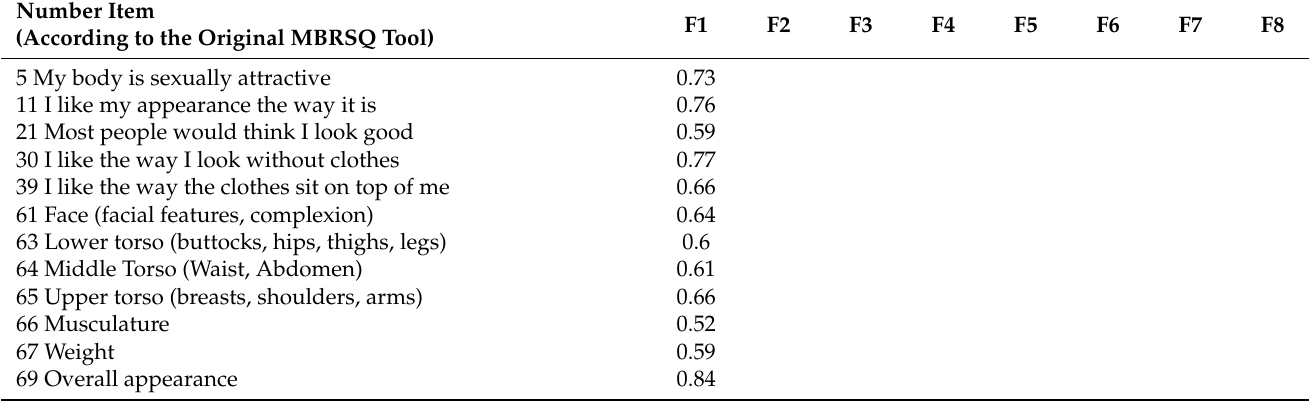
Table 2. Exploratory factor analysis of the MBSRQ-PL questionnaire.